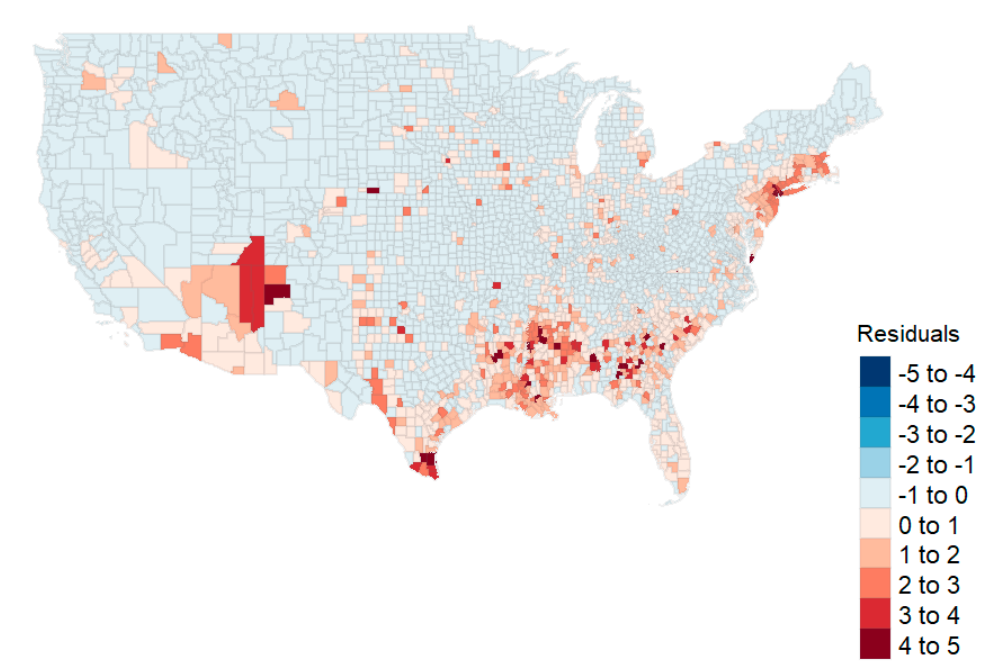
Figure 3. Residual plot from the Ordinary Least Squares (OLSs) model shows clusters in the Northeast and Southwest.